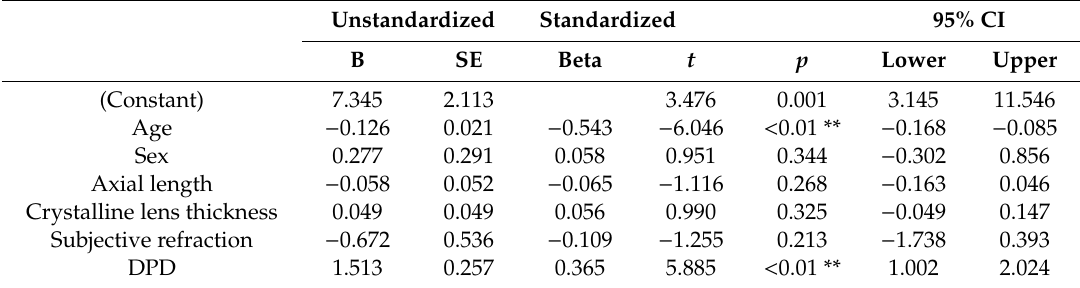
Table 2. Multiple regression analysis in all participants ( n = 95 and adjusted R 2 = 0.712).